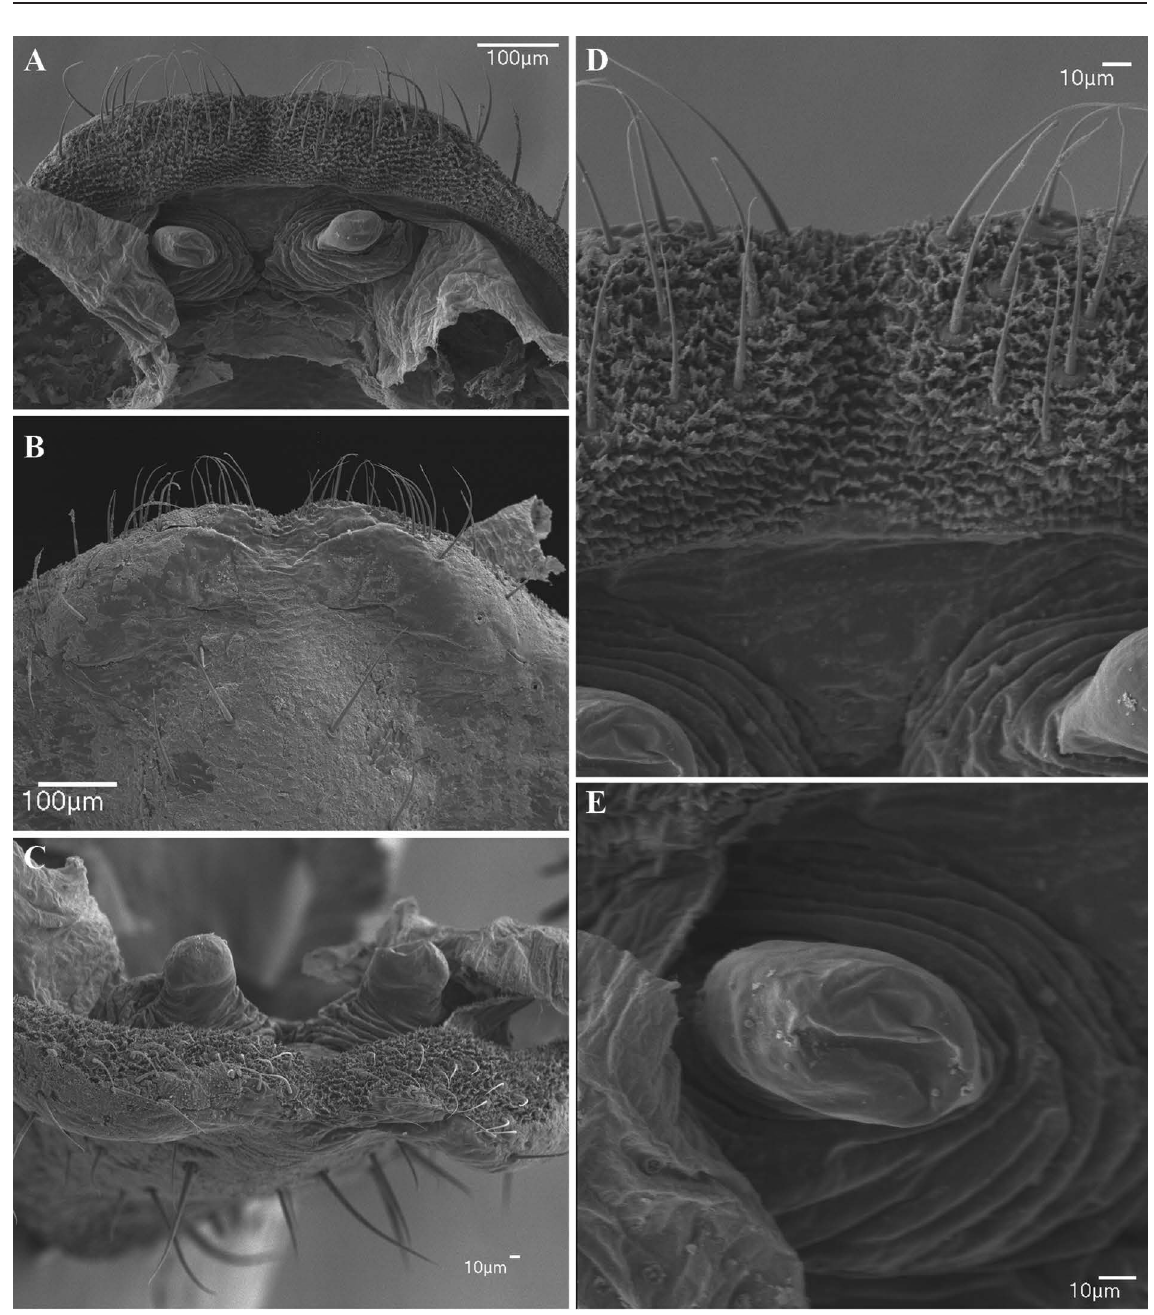
Fig. 115. Sarax javensis (Gravely, 1915) (WAM T80541), female gonopod and genital operculum. A . Finger-like gonopod, dorsal view. B . Posterior margin of genital operculum, ventral view. C . Gonopods, posterior view. D . Genital operculum between gonopods. F .